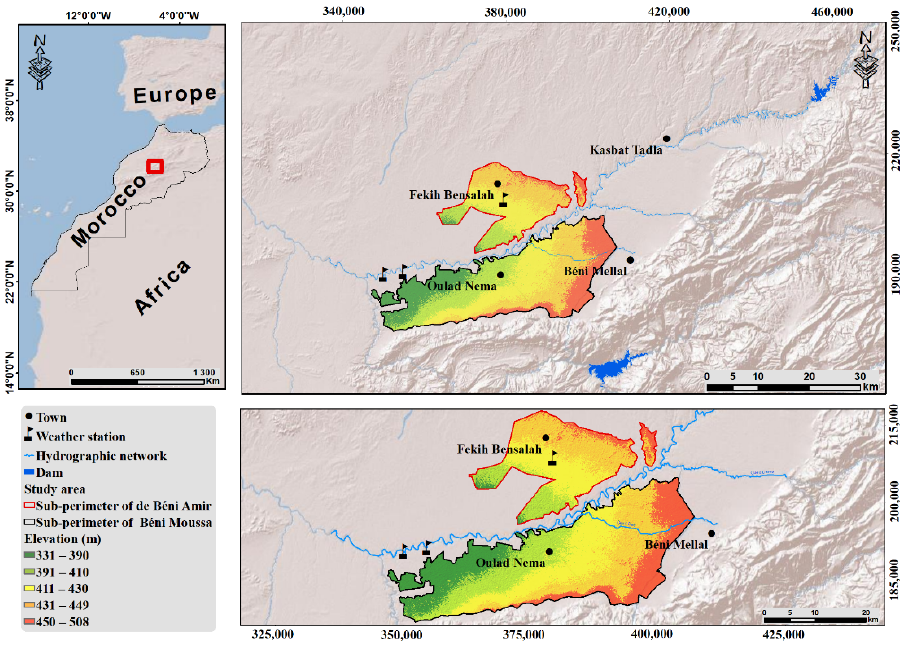
Figure 1. Location of the study area